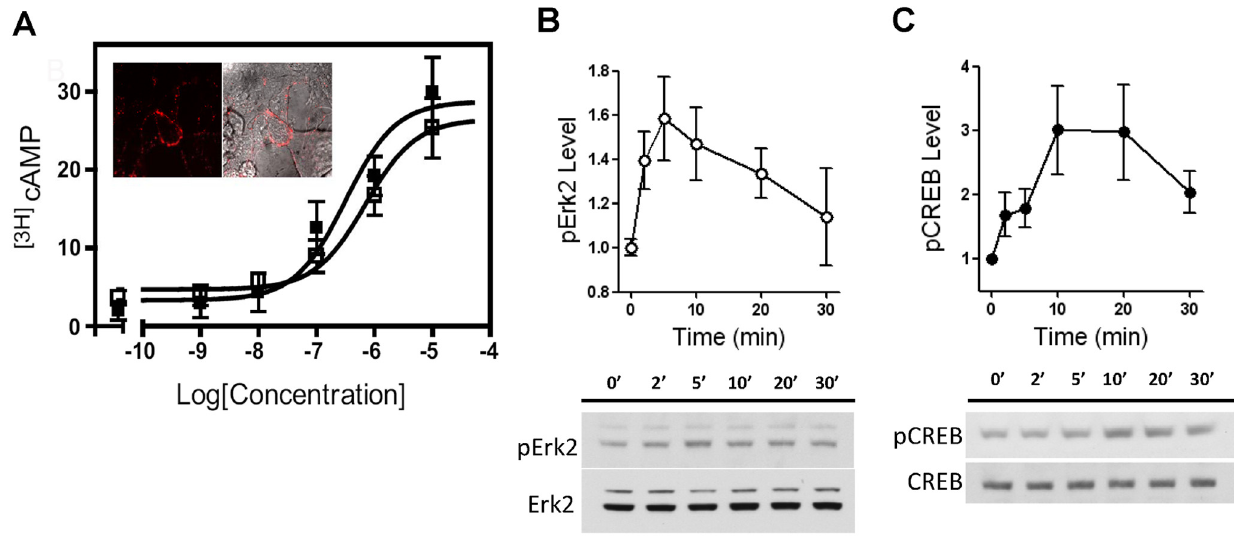
Figure 2. 3-MT induces activation of human TAAR1 in cAMP assay and causes CREB and Erk2 phosphorylation in HEK-293 cells. (A) cAMP response to tyramine and 3-MT in cells expressing hTAAR1 receptor. Dowex and Alumina column chromatography was used to measure [3H]- cAMP accumulation in HEK-293 cells transfected with the hTAAR1 receptor and treated with the concentrations of compounds shown in the Figure for 15 minutes at room temperature. Results are the mean 6 SEM of two (tyramine) or three (3-MT) independent experiments performed in duplicate. EC50 for tyramine was estimated as 320 6 100 nM and for 3-MT as 700 6 180 nM. No effects of tyramine and 3-MT were observed in corresponding Mock cells expressing endogenous receptors only (data not shown). The inserted images obtained with a Zeiss LSM510 confocal microscope show the fluorescence from the immunostaining of HA epitope tagged hTAAR1 receptors expressed at the plasma membrane compartment of non permeabilized HEK-293 cells (left image), and an overlay of the fluorescence on a phase image of the same cells (right image) [21]. (B) and (C) Time- course of effect of 3-MT (10 m M) on Erk2 (B) and CREB (C) phosphorylation in HEK-293 cells expressing hTAAR1. hTAAR1 was expressed in cells as described previously [21] and treated with vehicle or 3-MT (10 m M). The cells were lysed and then analyzed by Western blot for Erk2 and CREB phosphorylation. 3-MT produced time dependent phosphorylation of Erk2 and CREB in cells expressing hTAAR1 while no effects were observed in vehicle-treated controls. A significant effect in comparison to untreated cells (time point 0) was observed at 2, 5, 10 and 20 min time points for ERK2 phosphorylation and at 10 and 20 min periods for CREB phosphorylation (n=4 independent experiments per group, p , 0.05, one-way ANOVA followed by Dunnet’s multiple comparison test). No effect of 3-MT was observed in corresponding Mock cells without hTAAR1 expression (data not shown).